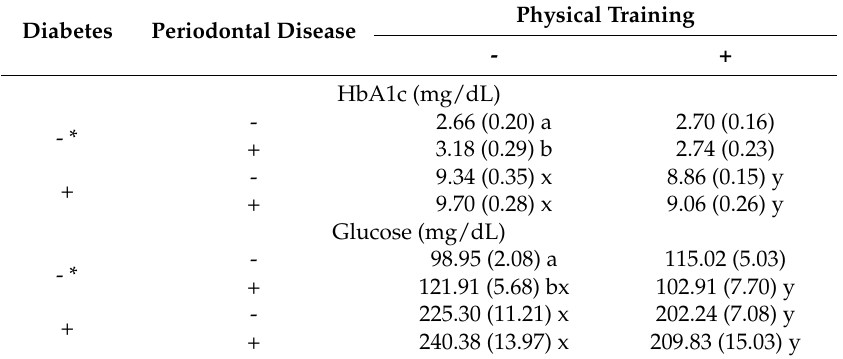
Table 2. Blood glucose and HbA1c concentrations of type 2 diabetic rats (HFD/STZ) with ligature-induced periodontal disease after eight weeks of physical training.